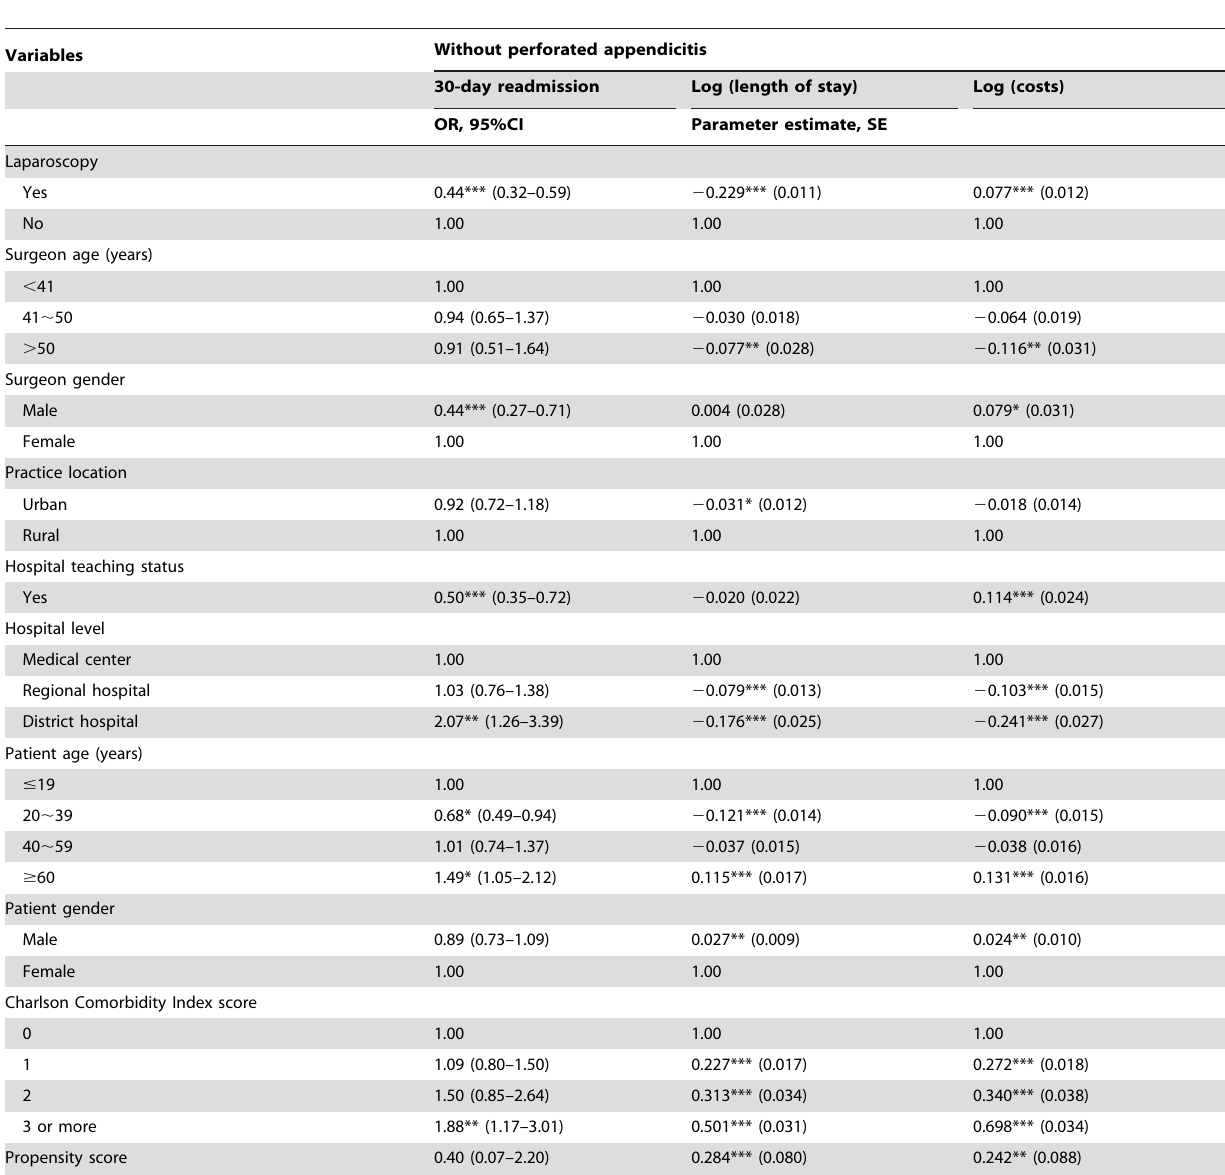
Table 5. Adjusted relationships between 30-day readmission, length of stay, cost per discharge, and the use of laparoscopy for patients with acute appendicitis (without perforated